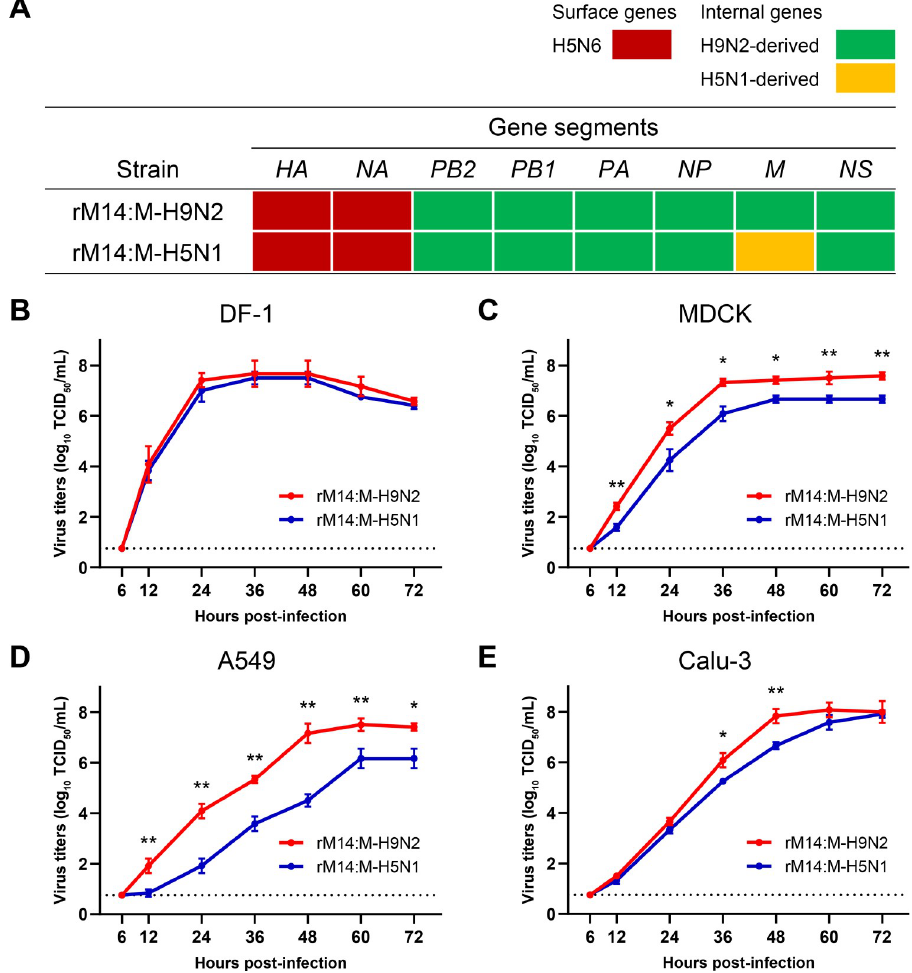
Fig 2. Reassortment of the H9N2 virus-derived M gene enhanced H5N6 virus replication in mammalian cells. (A) Gene origins of rM14:M-H9N2 and rM14:M-H5N1 viruses. (B-E) Multistep growth curves of rM14:M-H9N2 and rM14:M-H5N1 viruses in DF-1, MDCK, A549 and Calu-3 cells, respectively (MOI of 0.01). Virus titers were determined from the supernatants collected at the indicated time points. Statistical significance was based on one-way ANOVA ( � , P < 0.05; �� , P <